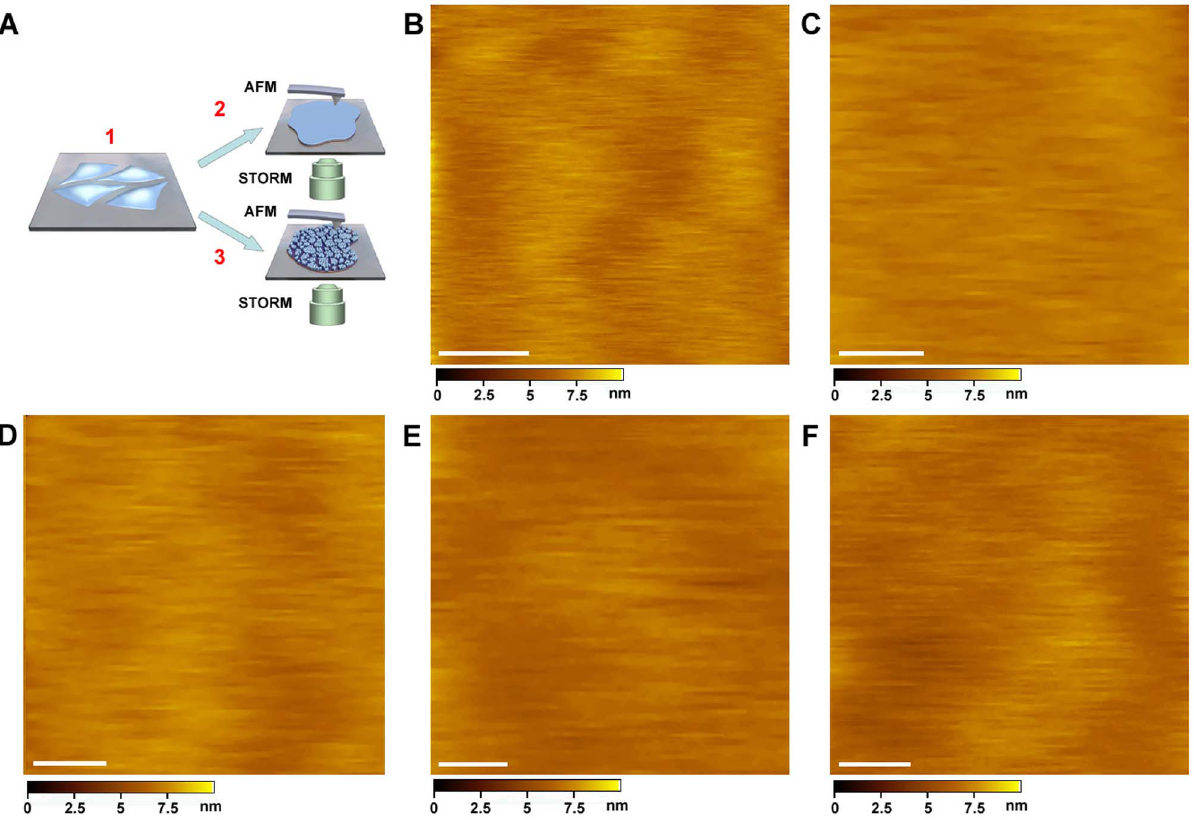
Figure 1. Imaging the ectoplasmic side of the cell membranes from various types of mammalian cells. (A) The scheme of this work. Cells were cultured on cover slips (A1), (A2) and (A3). The ectoplasmic and cytoplasmic sides of membranes were prepared separately and then investigated with AFM imaging, single-molecule force spectroscopy (SMFS), and STORM, respectively. (B) The ectoplasmic side of MDCK cell membrane was directly imaged on a living cell. (C) The image of the ectoplasmic side of the cell membrane (MDCK cells) prepared by shearing open the cells on a cover slip. (D) The image of the ectoplasmic side of the cell membrane (MDCK cells) prepared by centrifugation. (E and F) The ectoplasmic side of A549 (E) and HeLa (F) cell membranes prepared by the shearing open approach, respectively. Scale bars: 100 nm in (B–F).